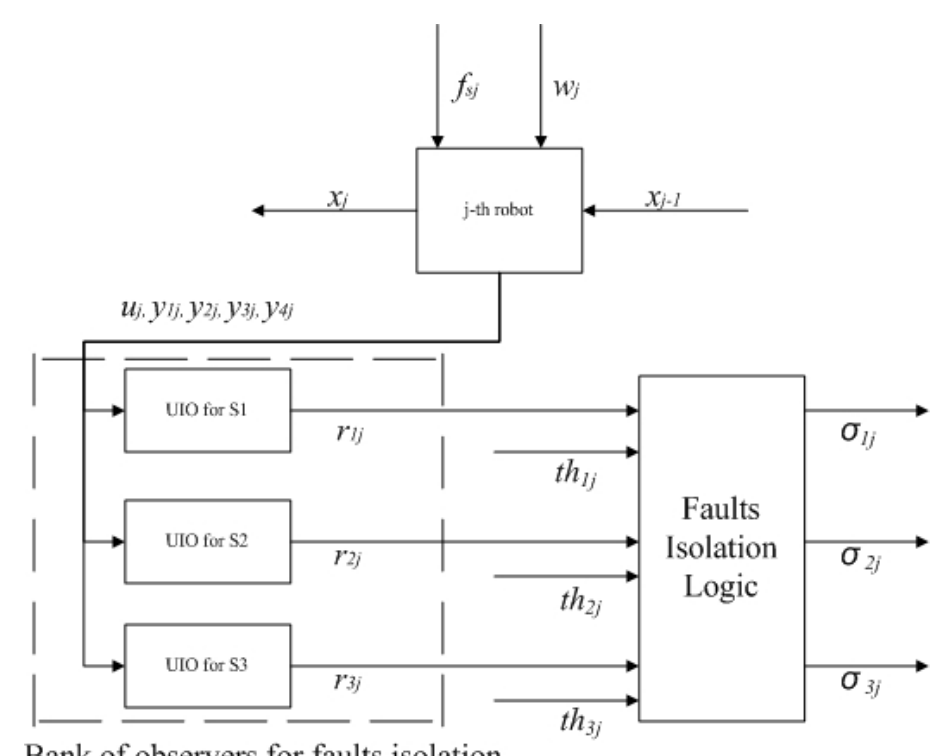
Figure 2. Local UIOs for sensor faults isolation on each